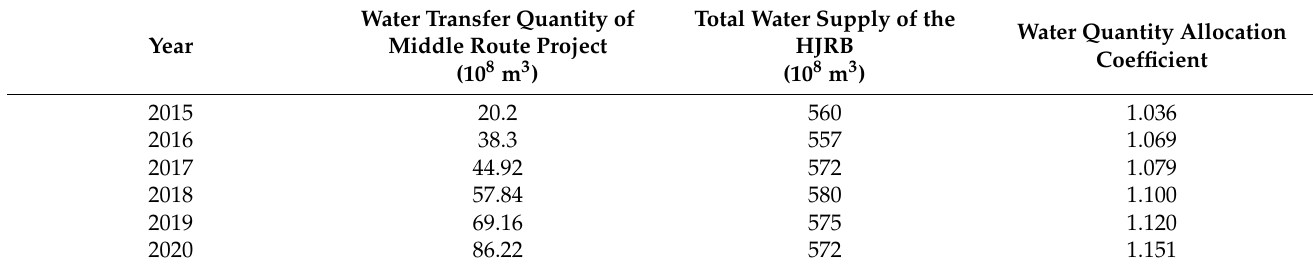
Table 4. Water quantity allocation coefficient of the main headwater areas from 2015 to 2020.